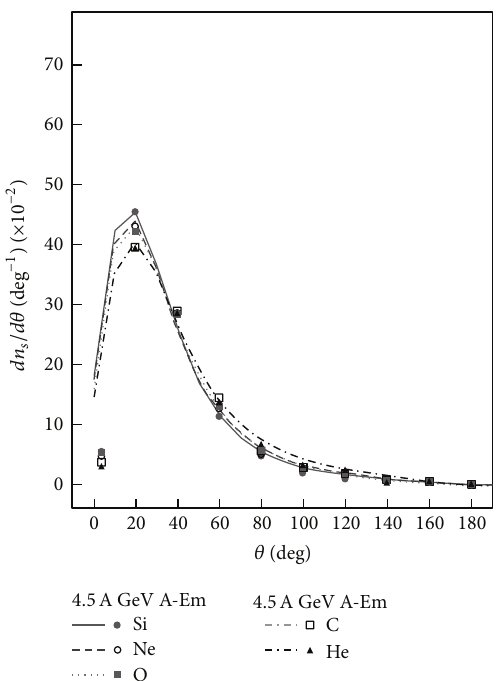
Figure 5: Angular distributions of shower particle produced in 4 He- (solid triangle), 12 C- (open square), 16 O- (solid square), 22 Ne- (open circles), and 28 Si- (solid circles) Em collisions at (4.1–4.5) AGeV/c. The symbols represent the experimental data. Capone the curves are our calculated results by multisource thermal model.